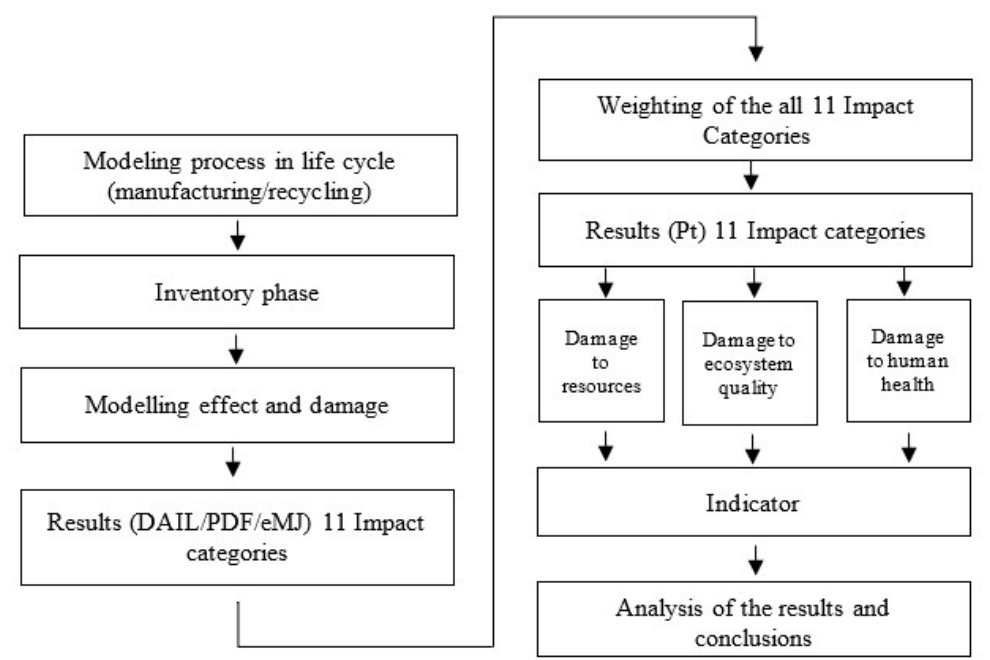
Figure 3. Detailed flow diagram of used methodology.